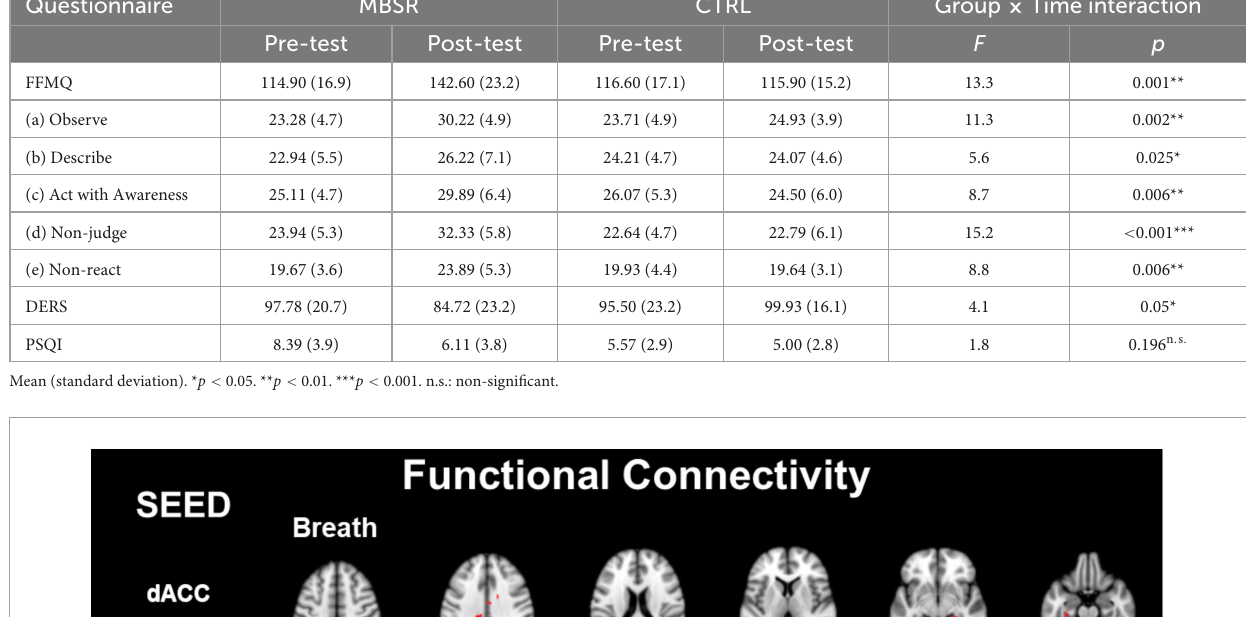
TABLE 2 Intervention effects of questionnaire scores between MBSR and CTRL groups. Questionnaire